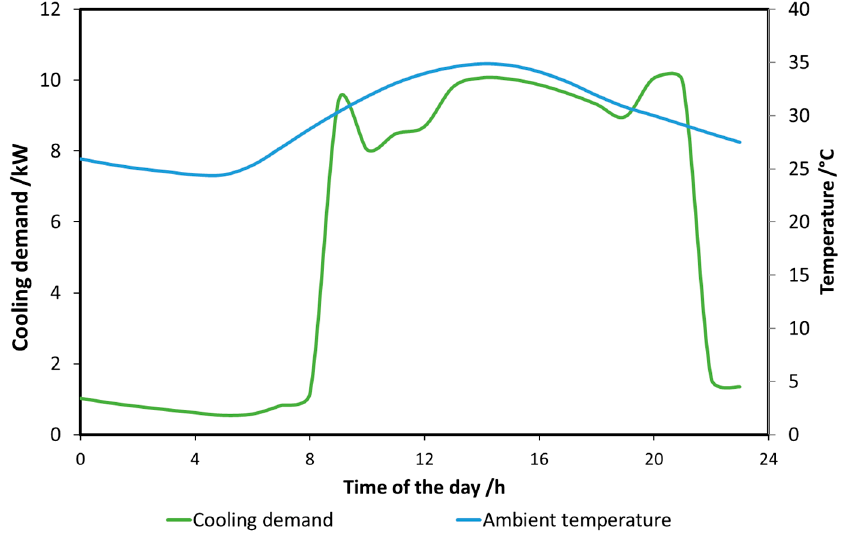
Figure 11. Boundary conditions for the dynamic simulation of the hybrid system - temperature and cooling demands for a reference day in Aglantzia